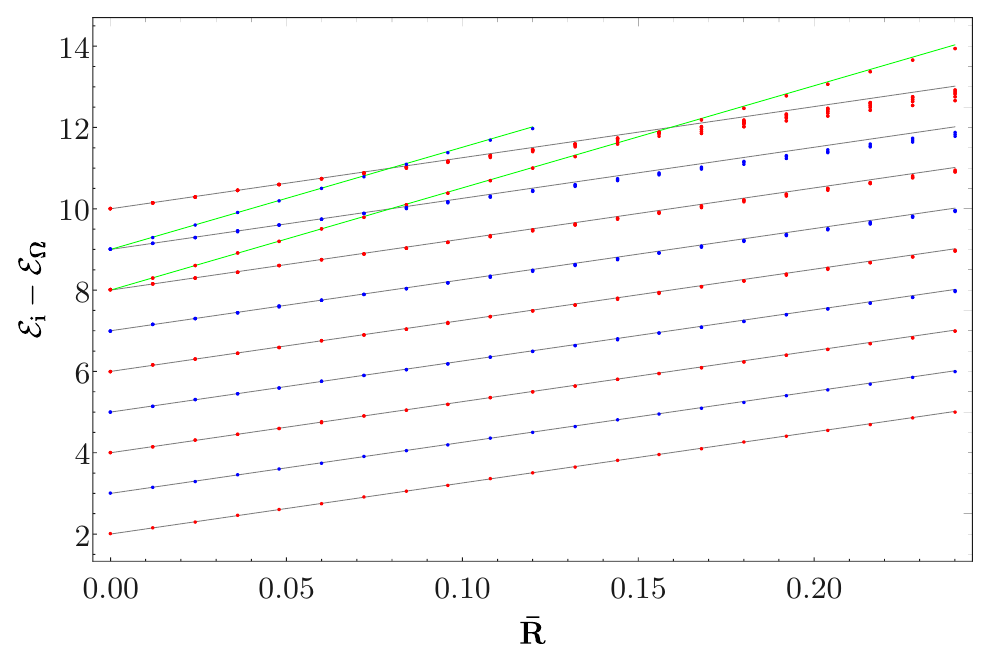
Figure 24. Spectrum of the Ising model with thermal deformation. The color distinguishes parity even (red) from parity odd (blue) eigenstates. The data is computed at Λ = 28 . Black and green lines mark the exact spectrum for the states with two and four fermions